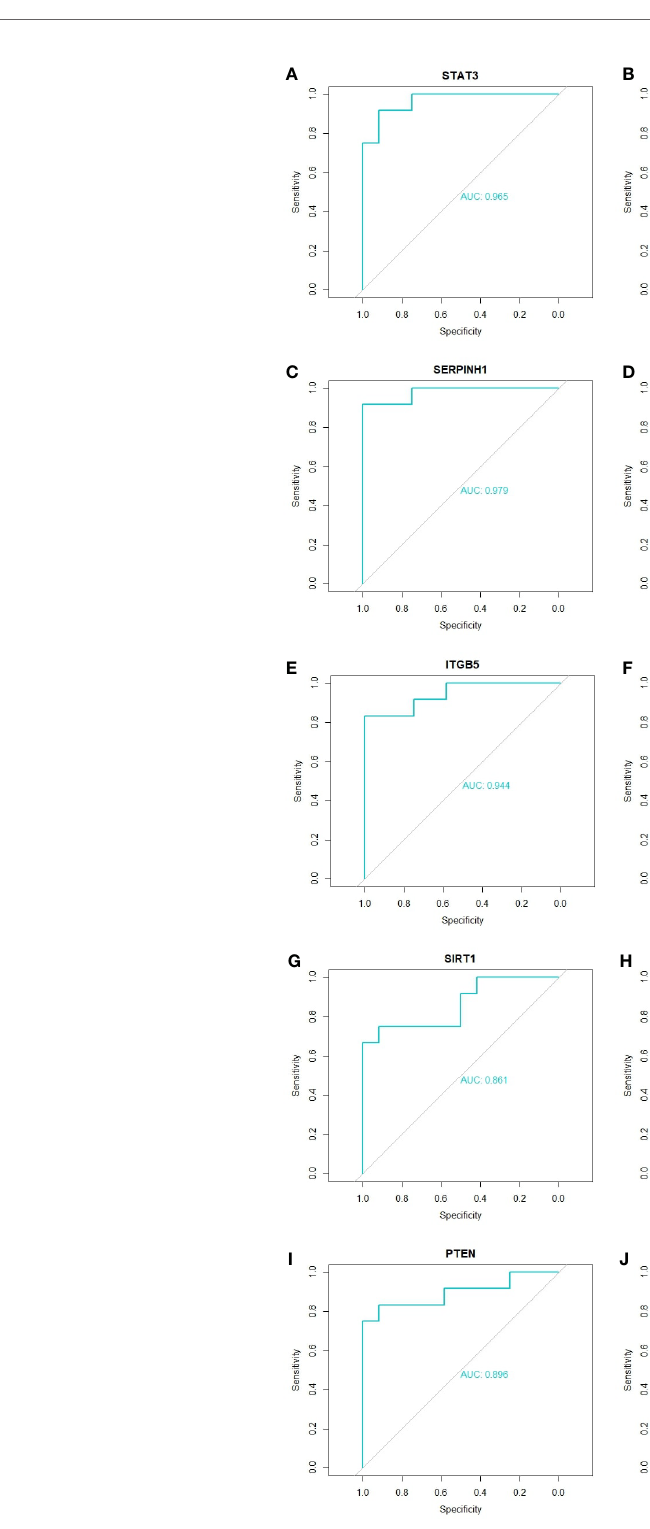
FIGURE 12 | ROC curve validated the sensitivity, speci fi city of hub genes as a predictive biomarker for obesity prognosis. (A) STAT3 (B) CORO1C (C) SERPINH1 (D) MVP (E) ITGB5 (F) PCM1 (G) SIRT1 (H) EEF1G (I) PTEN (J)